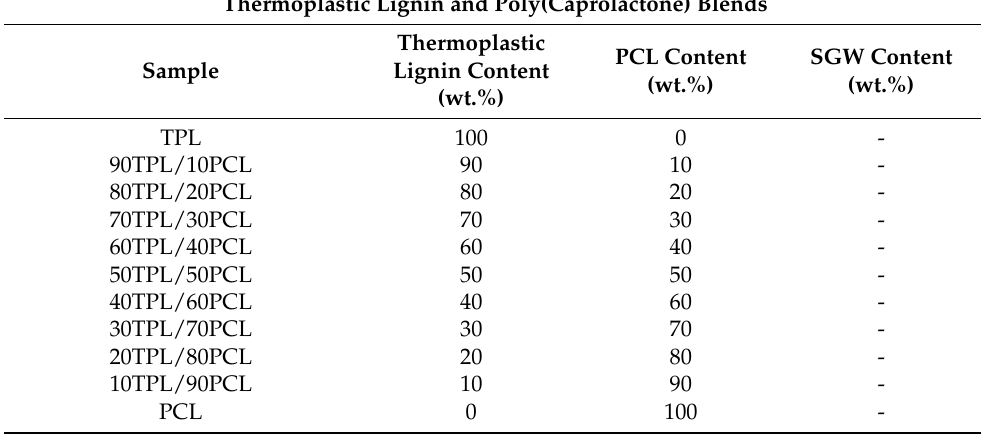
Table 1. TPL and PCL blends and SGW composite